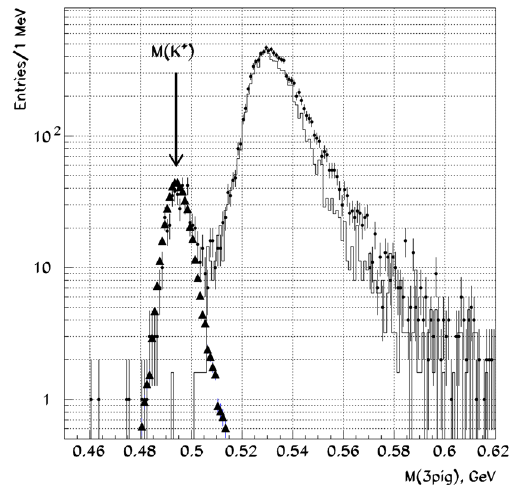
Fig. 4 The invariant mass distribution of the 3 πγ system for the data (black circles), main sources of background (histogram) and the MC signal (black triangles)